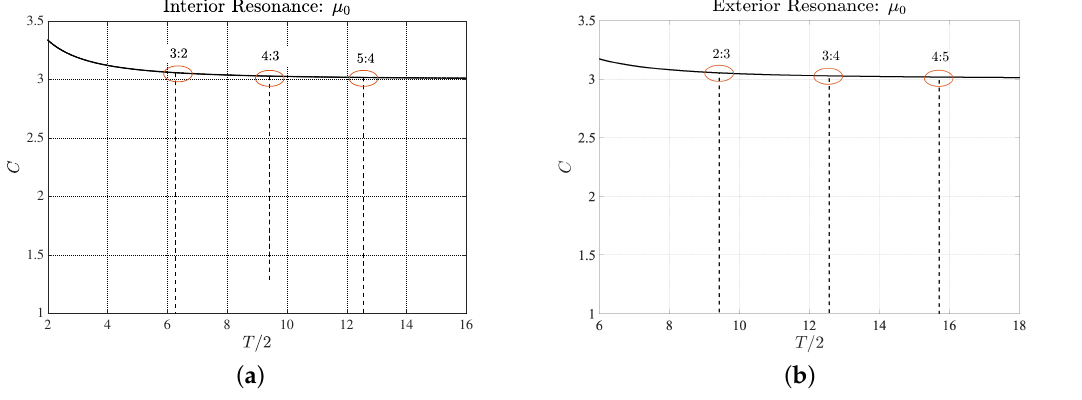
Figure 3. Characteristic curves of the circular families and the first-order resonant periodic families in the unperturbed model. The solid lines indicate the circular families and the dashed lines indicate the resonant periodic families. ( a ): Interior circular family and the interior first-order resonant periodic families (3:2, 4:3, and 5:4 resonances). ( b ): Exterior circular family and the exterior first-order resonant periodic families (2:3, 3:4, and 4:5 resonances). The abscissa is half the orbital period ( T /2) in the synodic frame and the ordinate is the Jacobi constant C